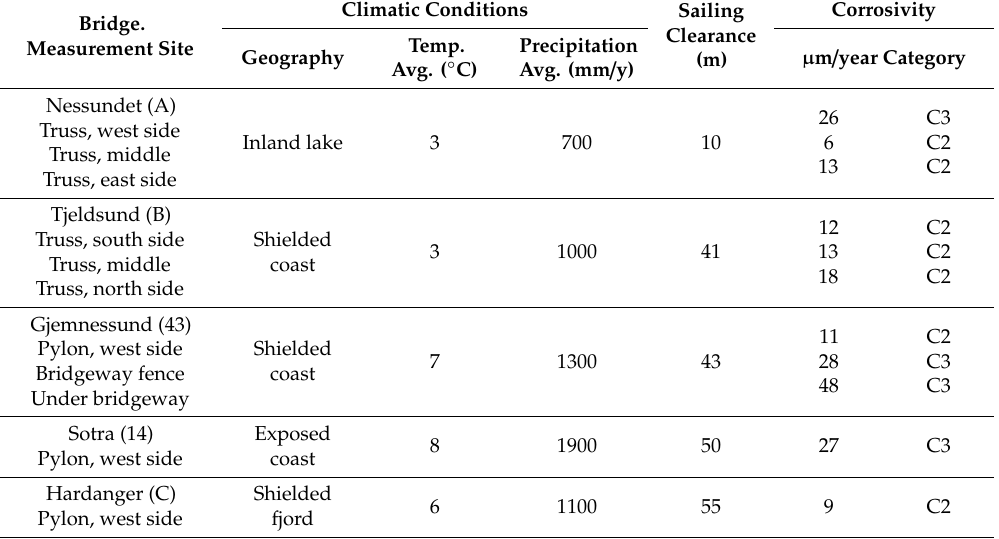
Table 3. The description of the bridges where corrosivity was measured and the corrosivity found at the level of the